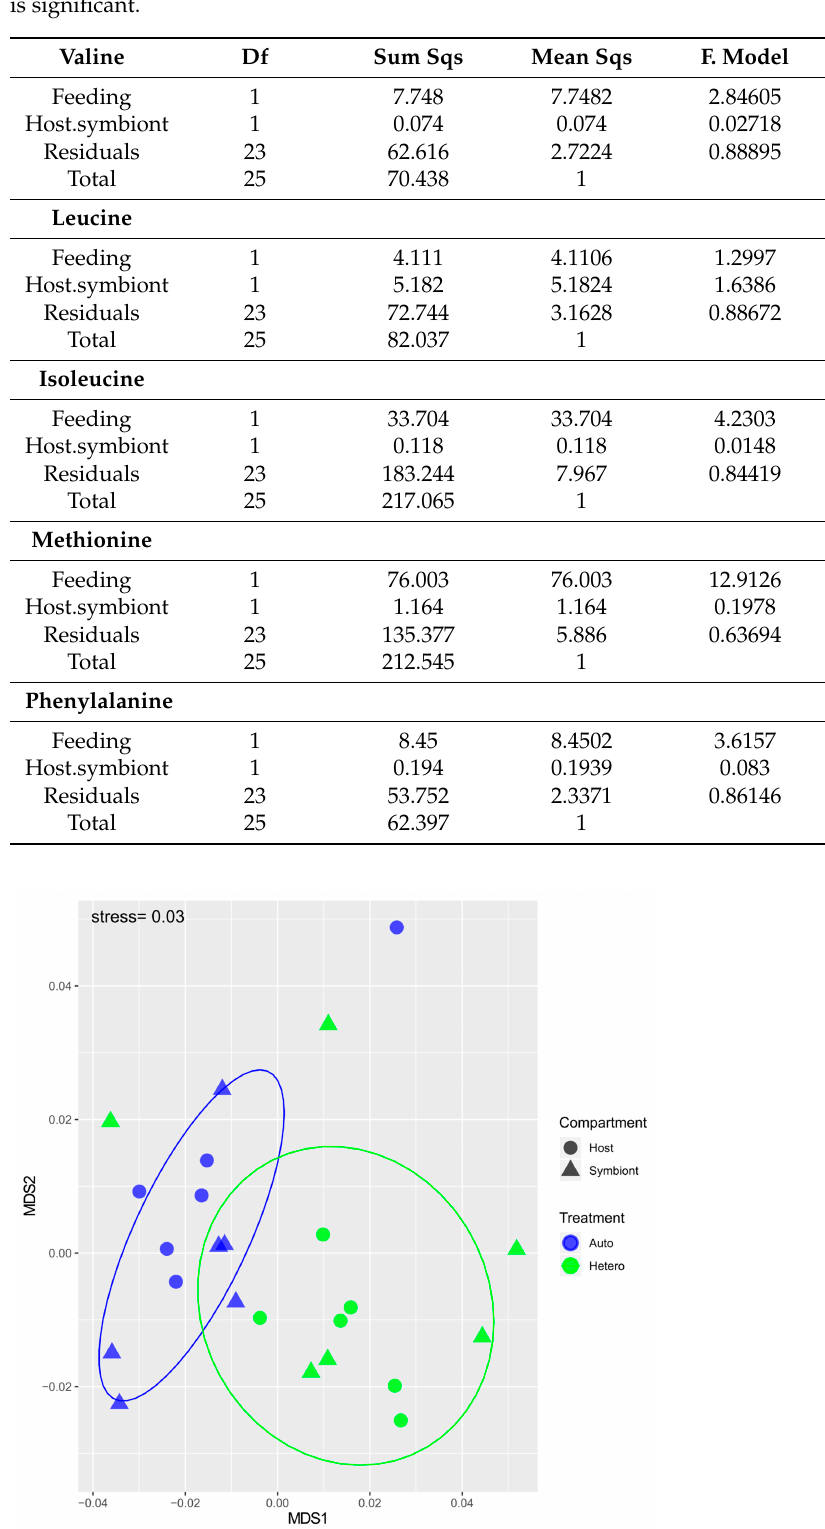
Table 2. The results from the statistical analysis testing the difference in δ 13 C value of the essential amino acids between the nutritional status, or the compartments (host versus symbiont). p ≤ 0.05 is significant.